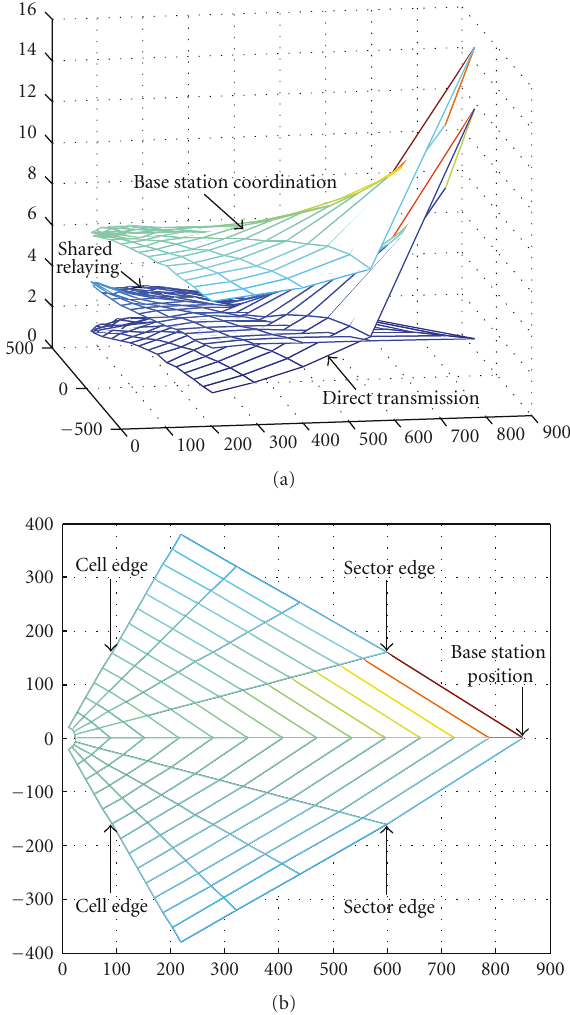
Figure 10: (a) Downlink sum rate in one sector versus mobile station position for base station coordination, shared relaying, and direct transmission. A reuse factor 6 is shown because the curves are more separated in this case. By adapting between shared relaying and direct transmission depending on user location, the rates of base station coordination can be approached. (b) The geometry of the sector, explaining the x - and y -axes of part